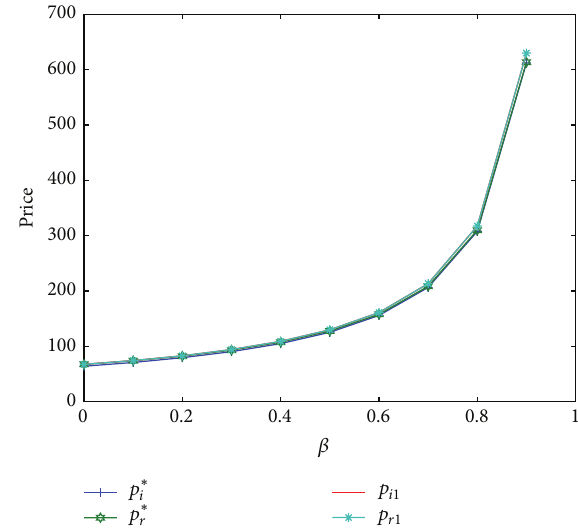
Figure 5: Impact of 𝛼 1 on pricings under demand certainty and uncertainty.